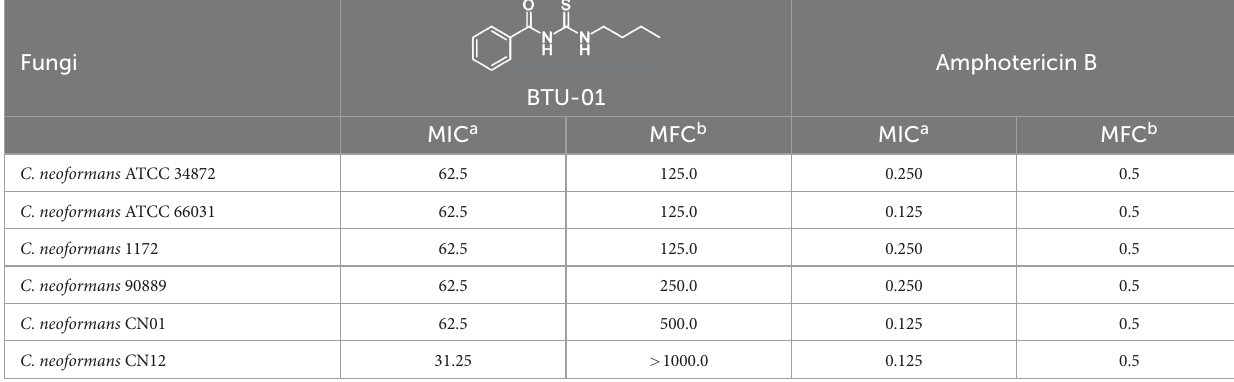
TABLE 1 Minimal inhibitory concentration (MIC) and minimal fungicidal concentration (MFC) of N -(butylcarbamothioyl) benzamide (BTU-01) and amphotericin B for Cryptococcus neoformans .